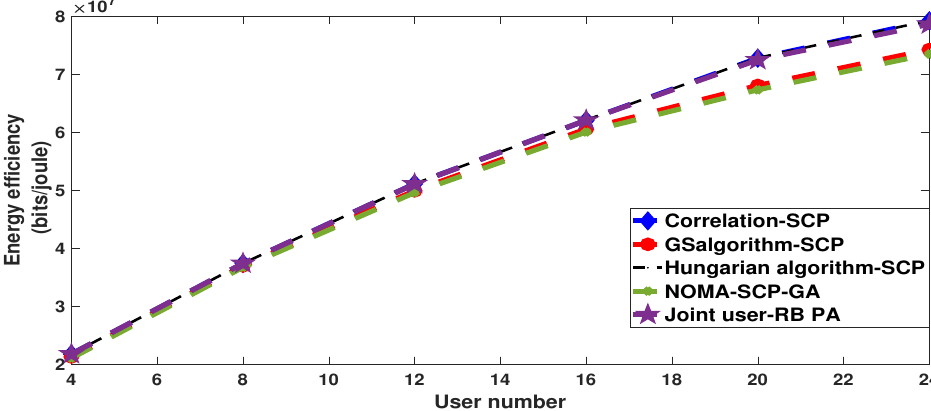
Figure 3. EE versus number of users, with A = 36 BS antennas, ZF beamforming.